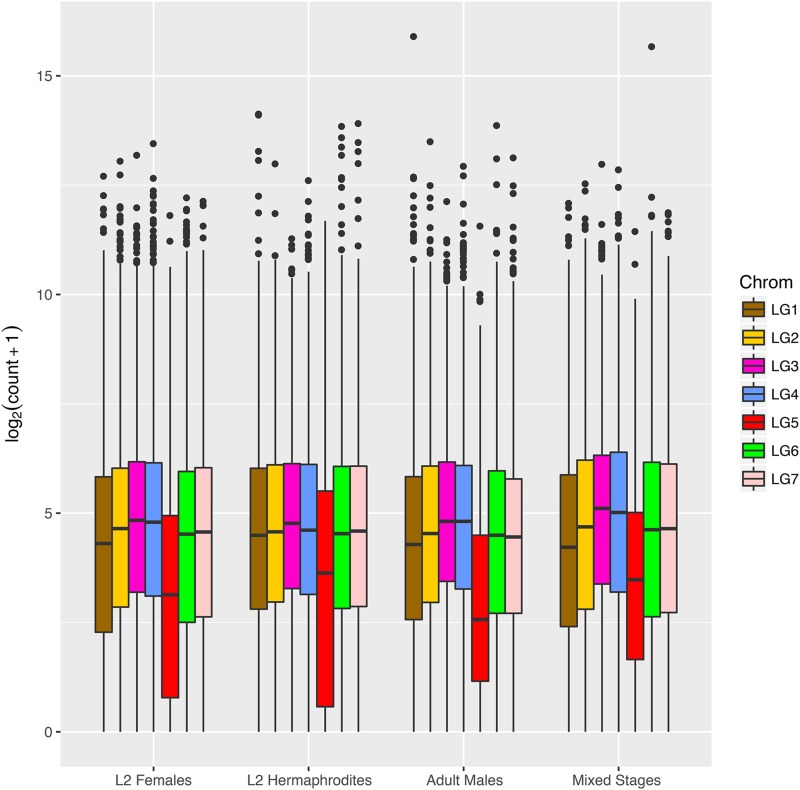
Expression of genes on the A. rhodensis X chromosome is generally lower than those on autosomes. Boxplots of the log2 normalized expression of the genes located on each linkage group of A. rhodensis in different sexes and stages in single replicate libraries. The expression levels were normalized by library size and log2-transformed. LG5 (in red) is the X chromosome. Boxplots for all libraries are represented in Figure S4. This plot was generated using the R package ggplot2 (Wickham 2016).